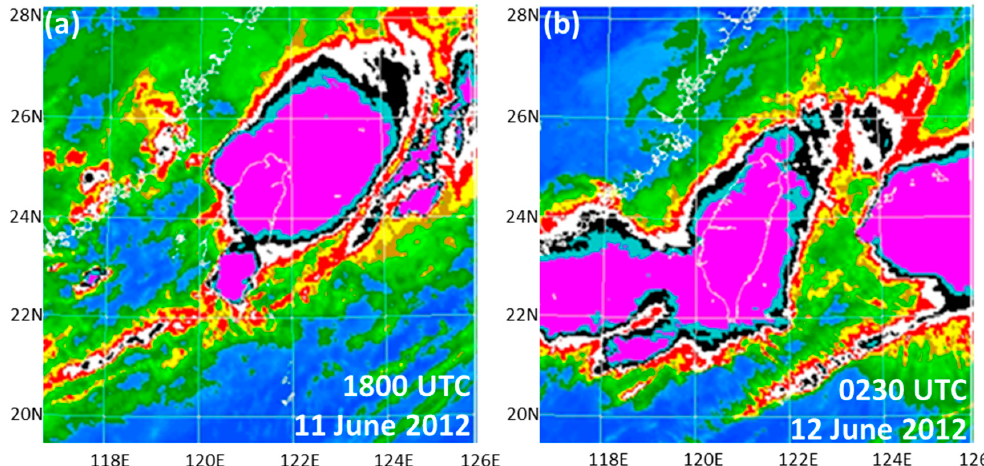
Figure 2. The color enhanced Japanese geostationary satellite (MTSAT-2) window channel brightness temperature imagery at wavelength of 11- μ m: ( a ) 1800 UTC on 11 June 2012; and ( b ) 0230 UTC on 12 June 2012. The pink color indicates the cloud tops with deep convection, which are typically associated with heavy precipitation at the surface.